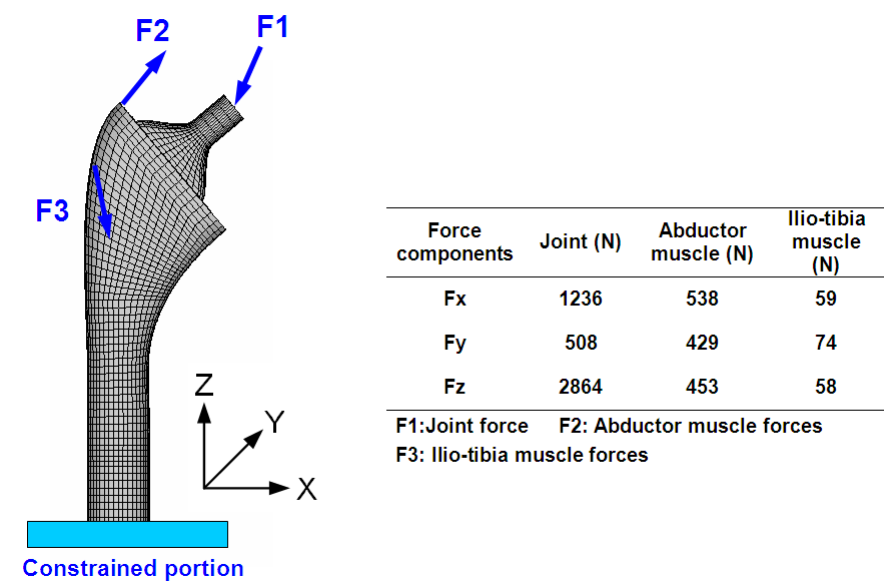
Figure 6. Schematic of joint force and muscle forces acting on the femoral head and femoral bone, which also shows the force components of gait loadings induced at gait phase of 45%.